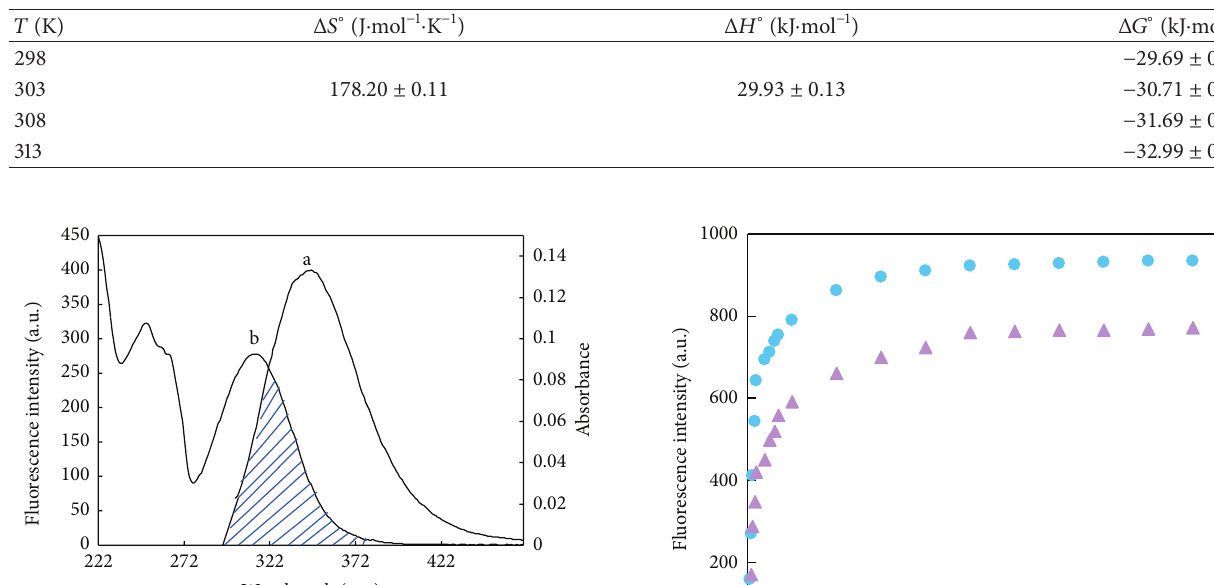
Table 2: Thermodynamic parameters for binding isoimperatorin to HSA.